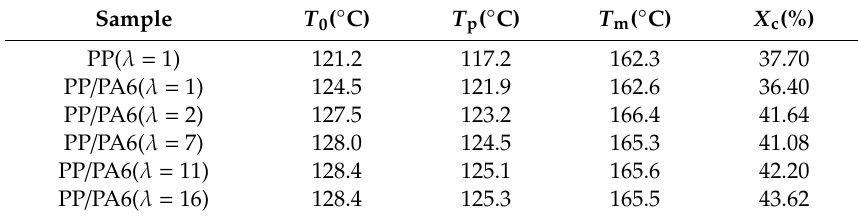
Figure 3. Di ff erential scanning calorimetry (DSC) thermograms of non-isothermal crystallization for the pure PP and the PP / PA6 blends with the stretch ratios of 1, 2, 7, 11 and 16: ( a ) crystallization curves; ( b ) melting curves; ( c ) wide-angle X-ray scattering (WAXS) patterns of the pure PP and the PP / PA6 blends with stretch ratios of 1, 2, 7, 11 and 16. Table 1. The thermal parameters for the non-isothermal